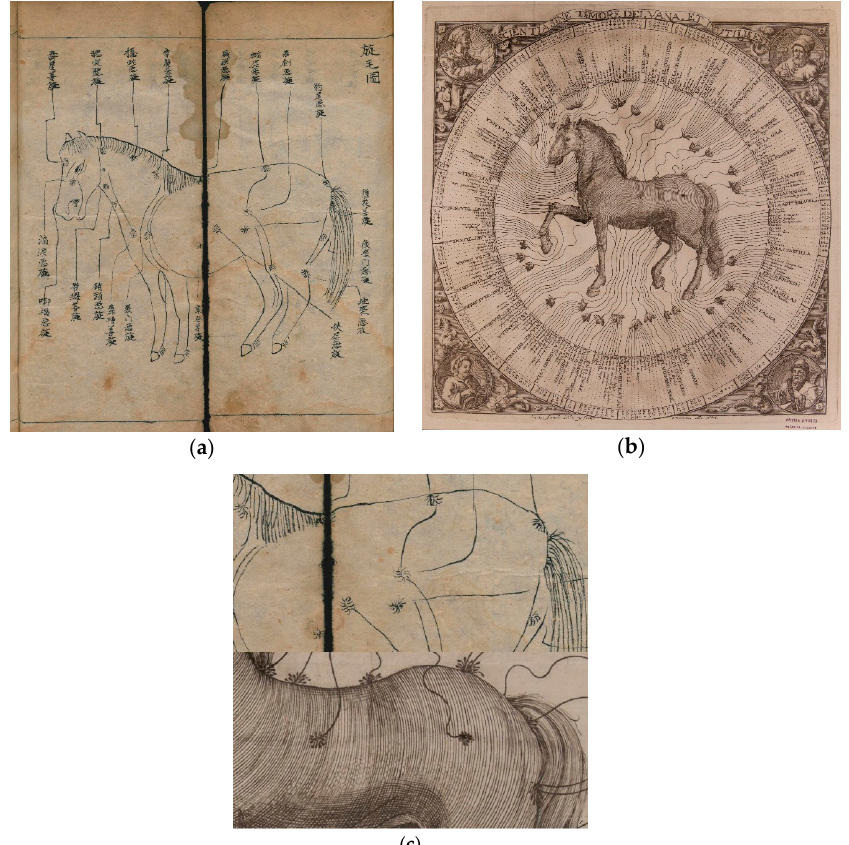
Figure 2. Analogies between ancient Chinese and European hippiatry treatises, with two examples